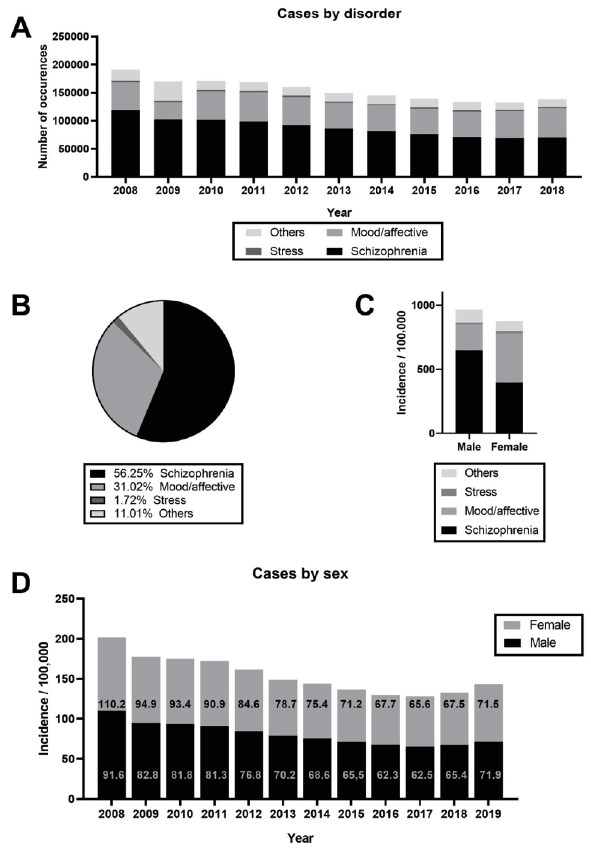
Figure 2. Total admissions by year of different disorders (A) and total occurrences from 2008 to 2019 by disorder type (B). Total admissions for each disorder type (C) and total annual incidence (D) by sex.